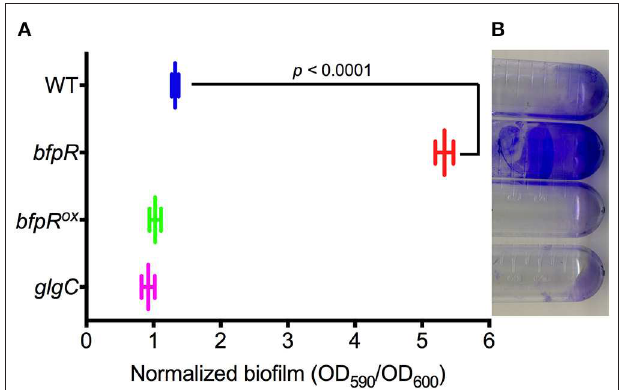
FIGURE 5 | Impact of bfpR on biofilm formation. (A) Quantification of biofilm formation of WT, bfpR , bfpR ox , and glgC, measuring crystal violet staining from triplicate experiments. bfpR produced significantly more ( p < 0.0001) biofilm than WT, bfpR ox , and glgC. (B) Representative image of biofilm formation on polystyrene